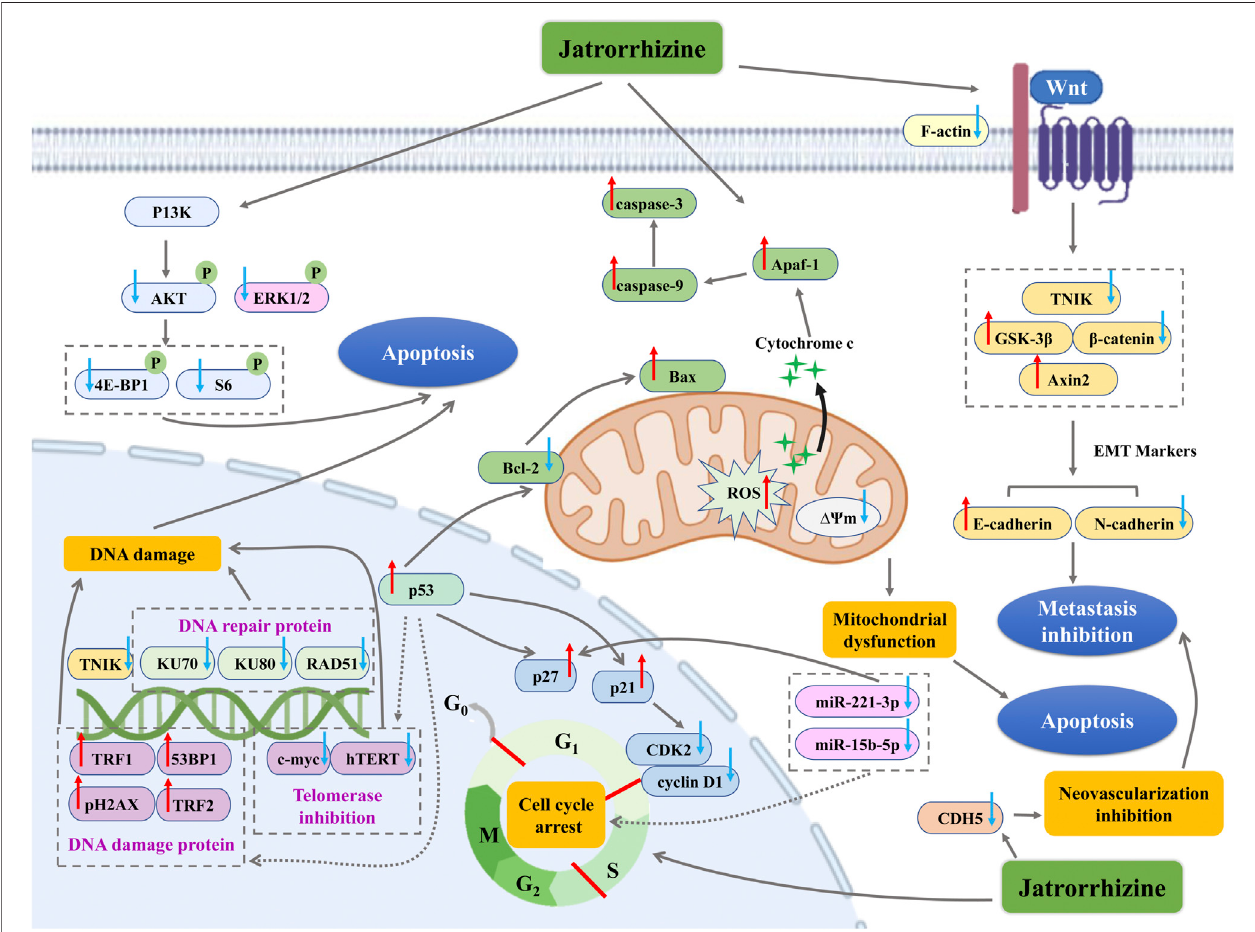
FIGURE 4 | The antitumor mechanism of jatrorrhizine. ↑ with red color indicate increase/promotion, ↓ with blue color indicate inhibition/reduction.